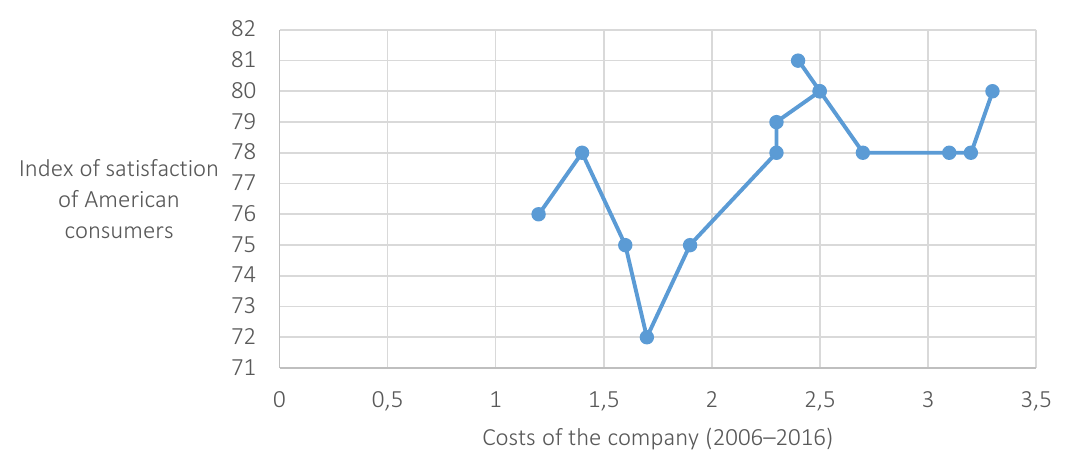
Figure 4. Correlation field for the index of satisfaction